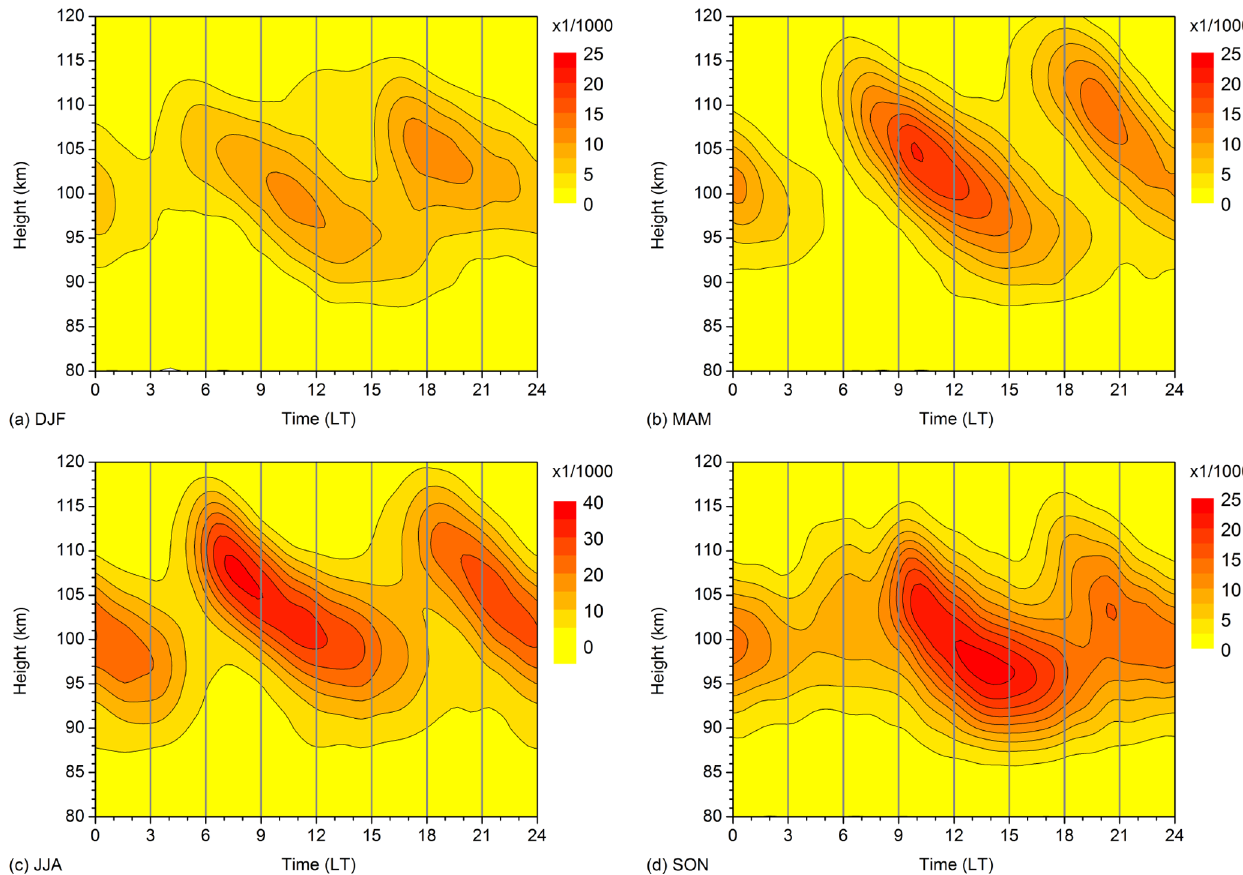
Figure 5. 2007–2016 mean seasonal mean diurnal cycle of Es occurrence rates for (a) DJF, (b) MAM, (c) JJA, and (d) SON in a latitude band 46–56 ◦ N and in height gates of 10km. Note the different scaling for